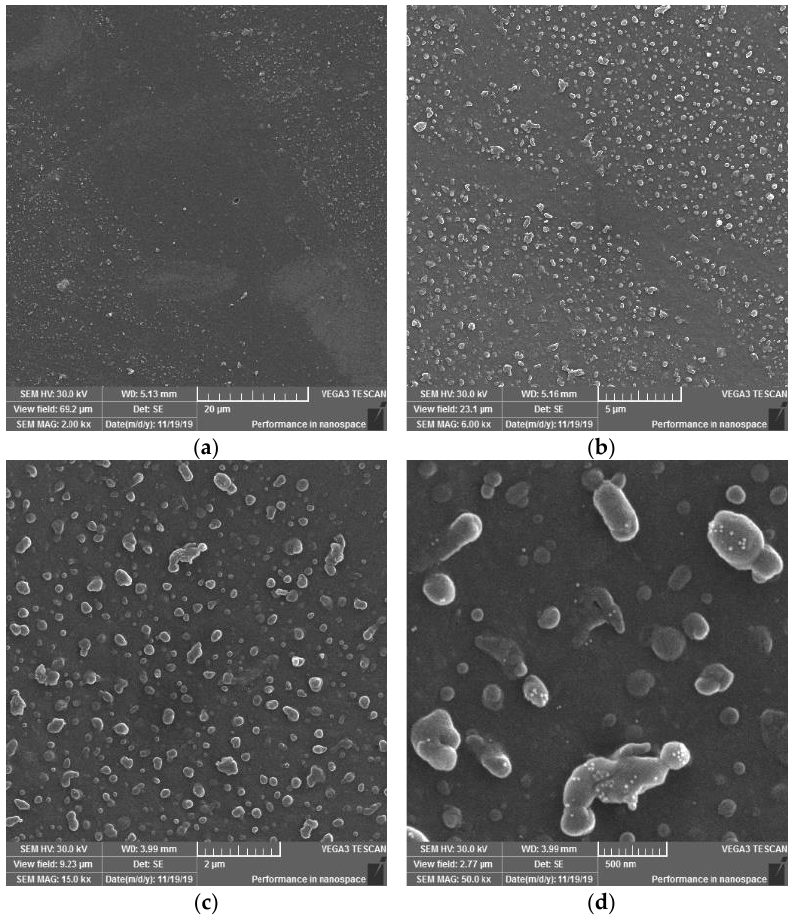
Figure 15. SEM morphology of the surface of plasma modified PVC exposure type IV. Observed magnifications: 2000× ( a ) , 6000× ( b ), 15,000× ( c ), 50,000× ( d ).